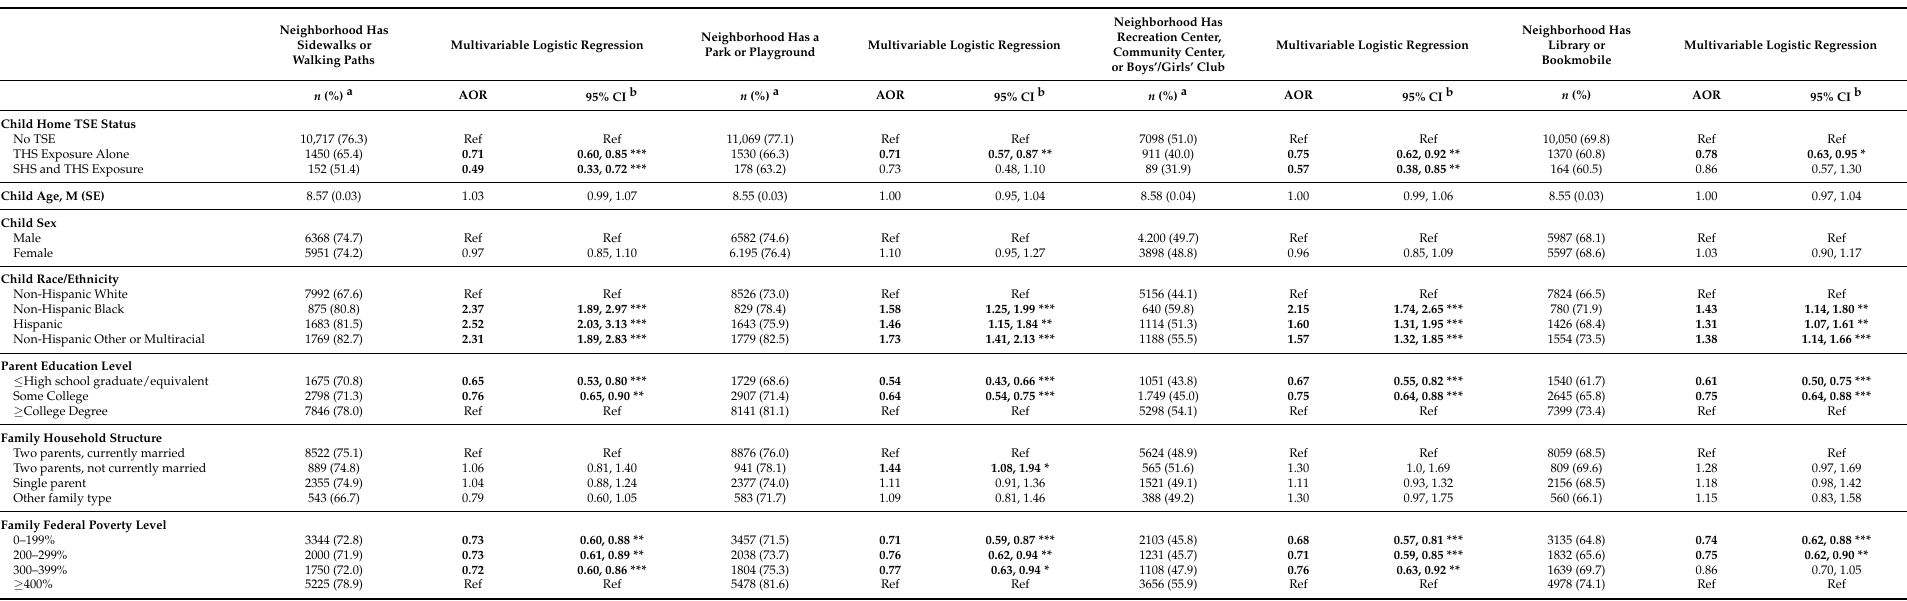
Table 3. Child home TSE status and type of neighborhood amenities among U.S. children 6–11 years old, 2018–2019